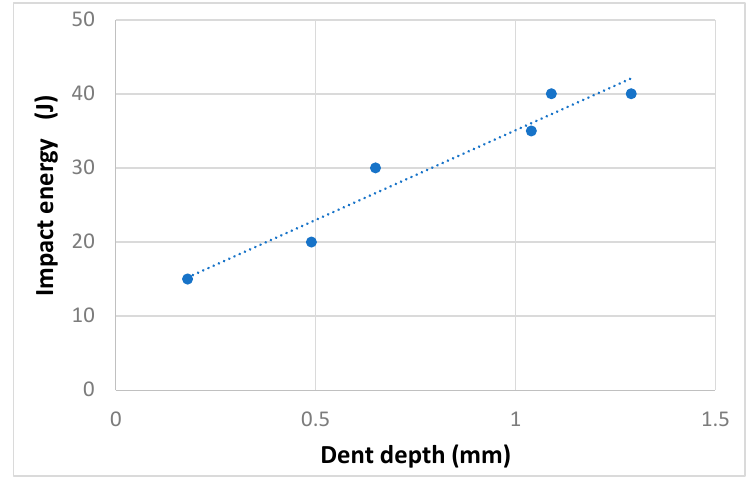
Figure 12. Impact energy vs. dent depth dependence of small panels. Considering a slightly different door panel stiffness compared with the small panel arrangement and previous skills, 40 J of energy was chosen as a base for door panel impact. Three impact points were created in different areas of the Omega profiles of the door panel (close to stop fitting, in the middle of the Omega flange, and in the radius). A general view of two omega profiles of a door panel with impact damage is shown in Figure 13. Due to various local panel stiffnesses, the dent depths of the impact damage differed. The impact damage test in the radius of the Omega profile web was repeated with a higher impact energy (45 J); therefore, the dent depth of the first impact with an energy of 40 J was significantly smaller than expected (0.35 mm). An overview of the dent depth of individual impact damage points is documented in Table 3.